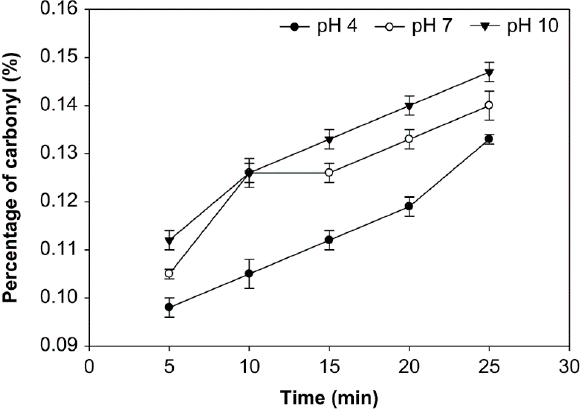
Figure 3. The effect of time on carbonyl group content at various pH with the starch concentration of 30% ( v / w ).